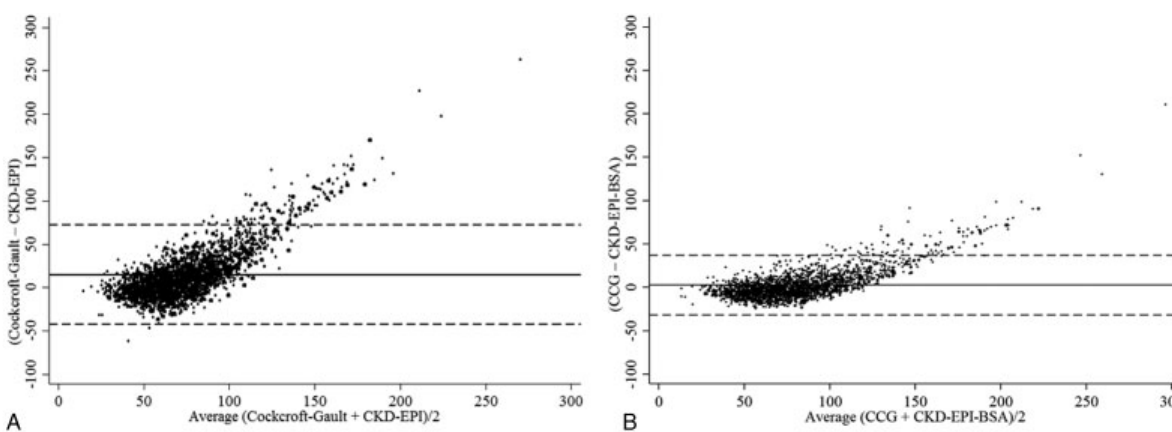
Fig. 2 Bland and Altman plots showing the within-person differences between the estimated CrCl obtained by using the Cockcroft – Gault equation and eGFR obtained by using the CKD-EPI equation (A) and CKD-EPI adjusted for body surface area (B) . The solid line indicates the mean difference and the dashed line indicates limits of agreement. CKD-EPI, chronic disease epidemiology collaboration; CKD-EPI-BSA, chronic disease epidemiology collaboration adjusted for body surface area. Table 2 Distribution of patients in each renal dose strati fi cation level for dabigatran etexilate % of patients in each dosing range CrCl/eGFR (mL/min)